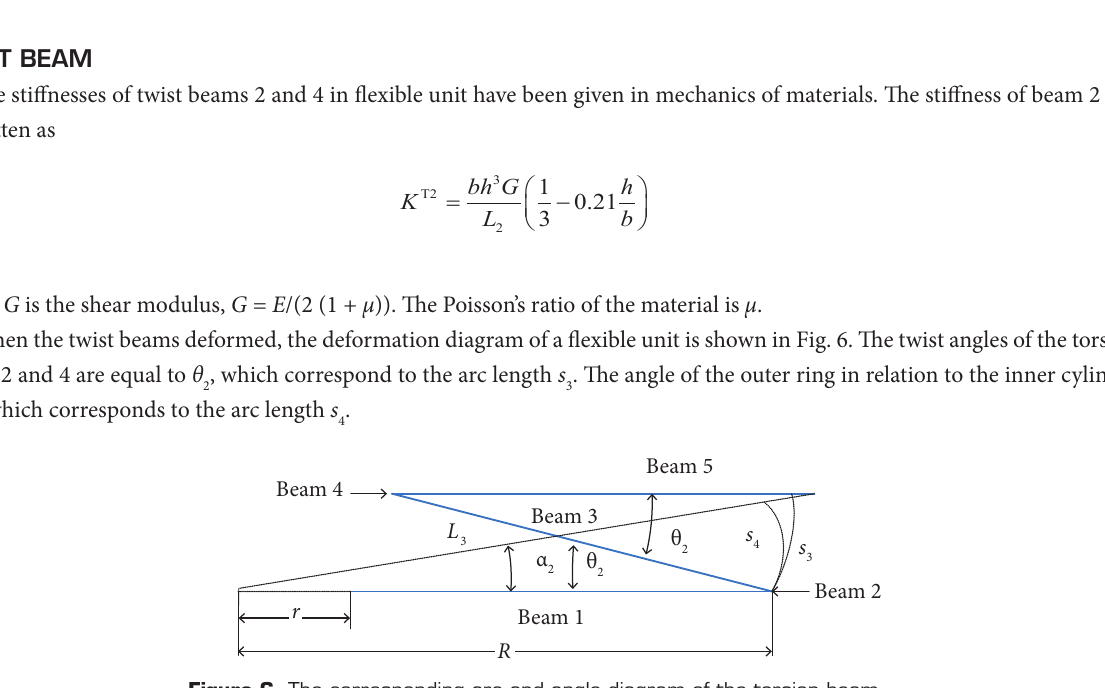
Figure 6. The corresponding arc and angle diagram of the torsion